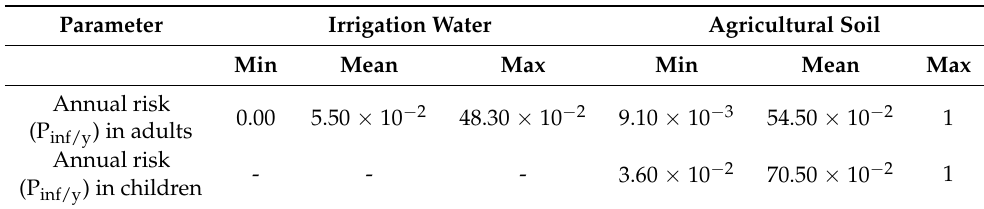
Table 5. The annual risk of infection due to ingestion of Listeria monocytogenes in irrigation water and agricultural